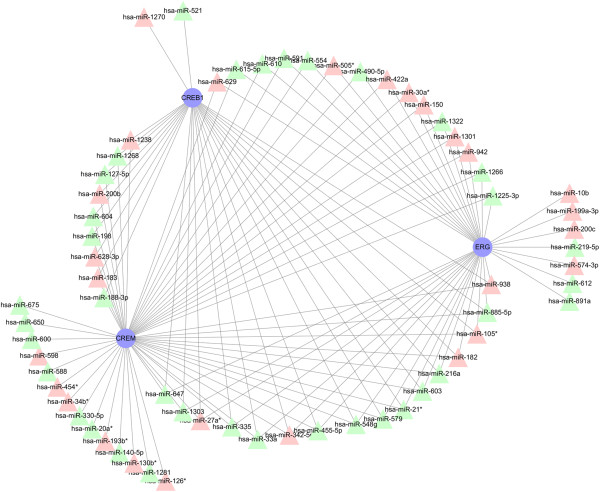
The regulating network of 3 main cancer related transcript factors (TFs) and differentially expressed miRNAs. Blue nodes are the TFs, red nodes are the up-regulated miRNAs, and green nodes are the down-regulated miRNAs. Edges represent the interactions between TFs and miRNAs.